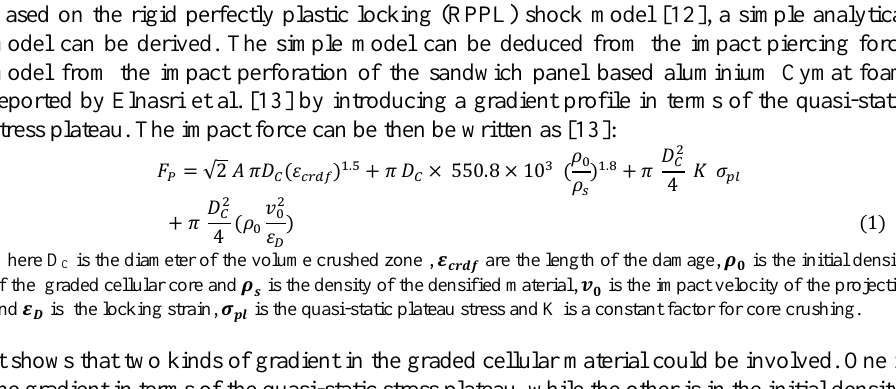
Table 2. Prediction of the energy absorption of the sandwich with the both numerical approaches. Sandwichs Energy absorbed (J) clumping conditions